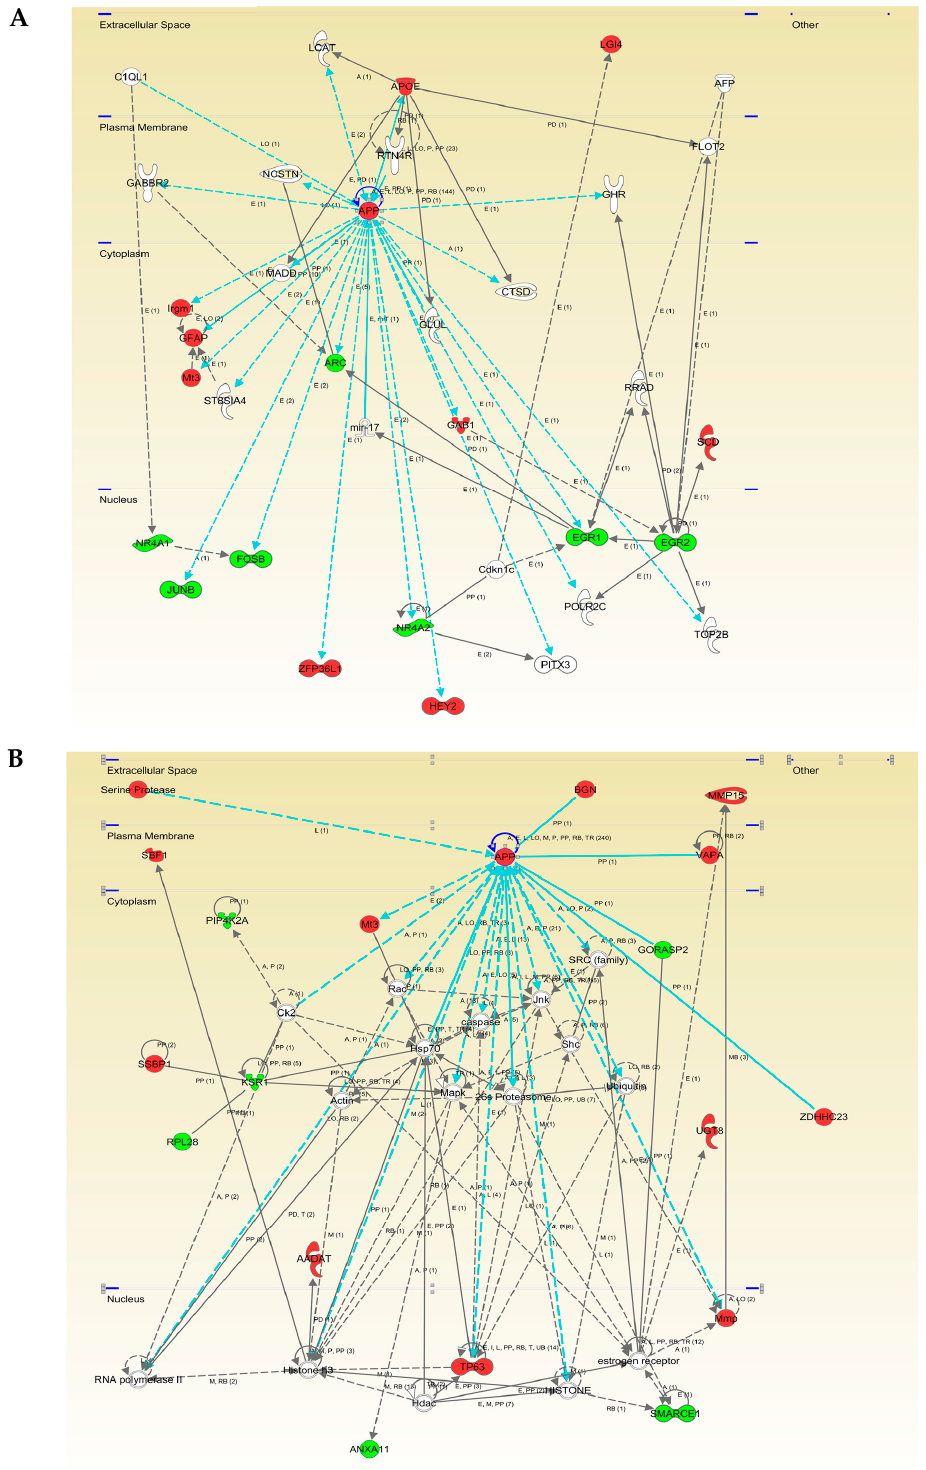
Figure 5. Modulation of APP molecular interaction network in the OB of aged Tg2576 mice. Visual representation of the relationships between differentially expressed genes/proteins and APP functional interactors (blue lines) are shown in both potentially deregulated networks in Tg2576 OBs ( A and B ). Continuous lines represent direct interactions, while discontinuous lines correspond to indirect functional interactions. Up-regulated molecules are shown in red, down-regulated molecules in green, and proteins proposed by the software in white. The complete legend of this type of interactomes may be found at http://ingenuity.force.com/ipa/articles/Feature_Description/Legend (accessed on 10 October 2017).